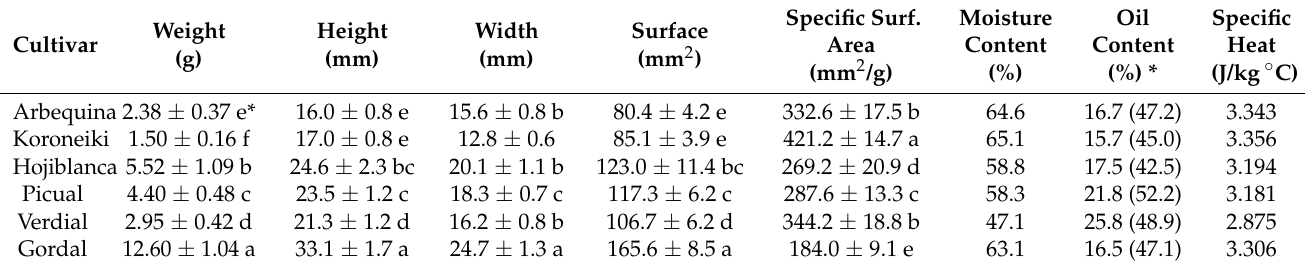
Table 1. Biometrical data, moisture and oil contents, and specific heat (C p ) of six different cultivars ( n = 25) of olives.